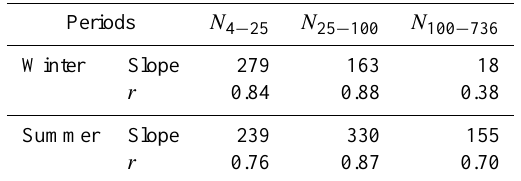
Table 4. Pearson correlation coefficient ( r) and slope of linear regression of PNCs against NO x during the nighttime (20:00– 04:00LT) in winter and summer periods.